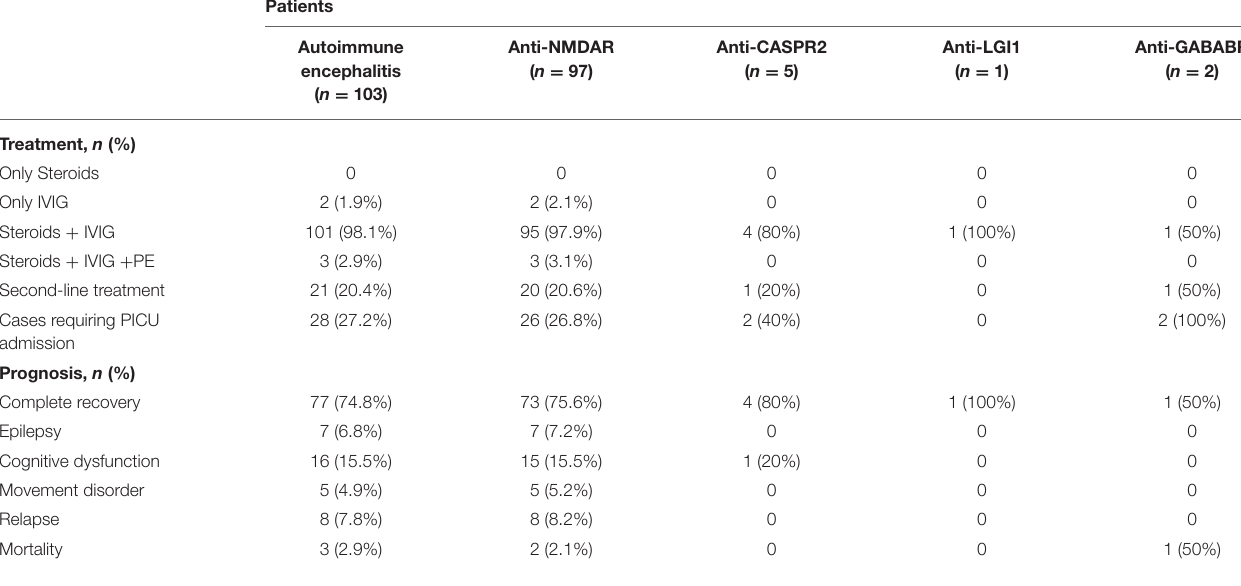
TABLE 3 | Summary of treatment and outcome results of AE